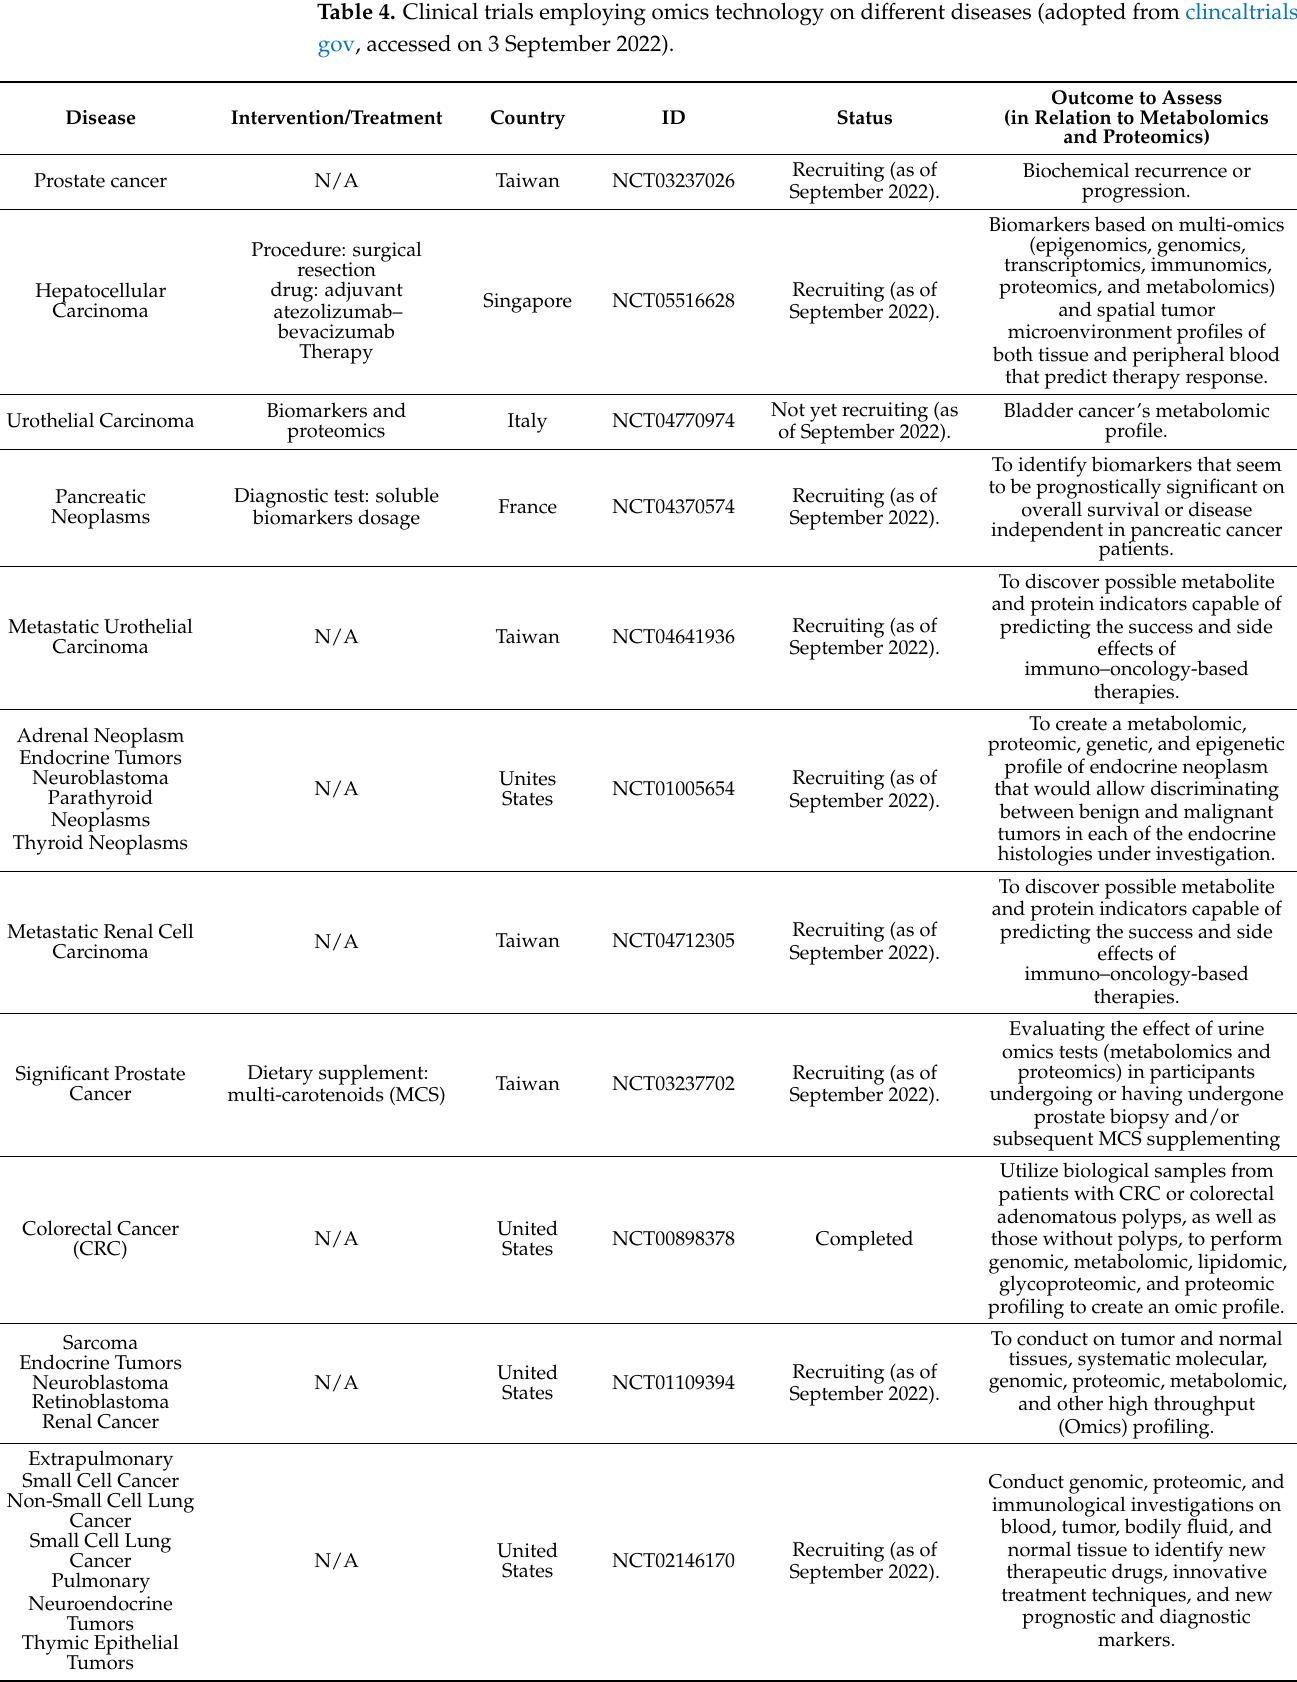
Table 4. Clinical trials employing omics technology on different diseases (adopted from